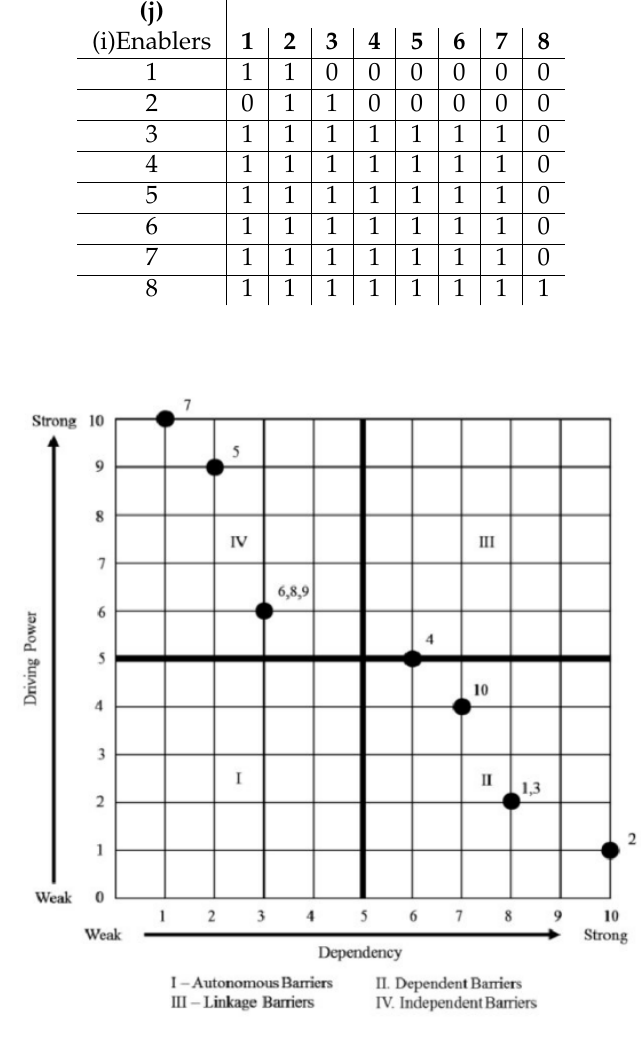
Figure 2. MIC-MAC